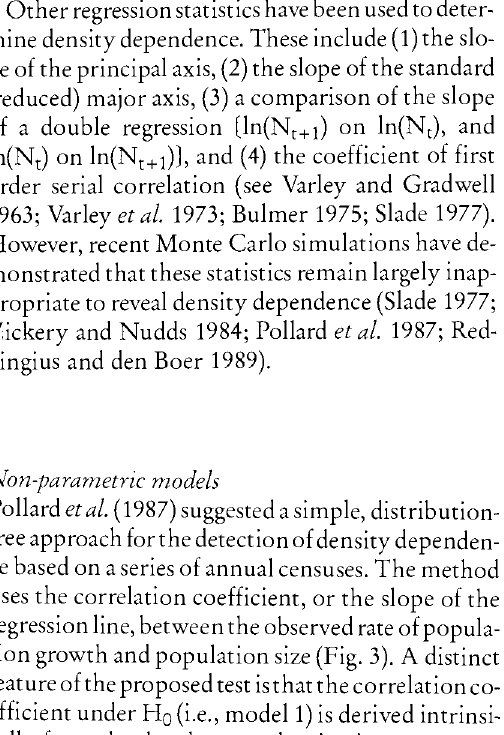
Figure 2. Test of density dependence proposed by Varley and Gradwell (1960), when applied to estimates of annual total mortality rates (k tota [) versus log population size (N t ). Density independence (DI) should be associated with a slope of 0, whe reas density dependence (DD) should be indica ted by a slope greater than